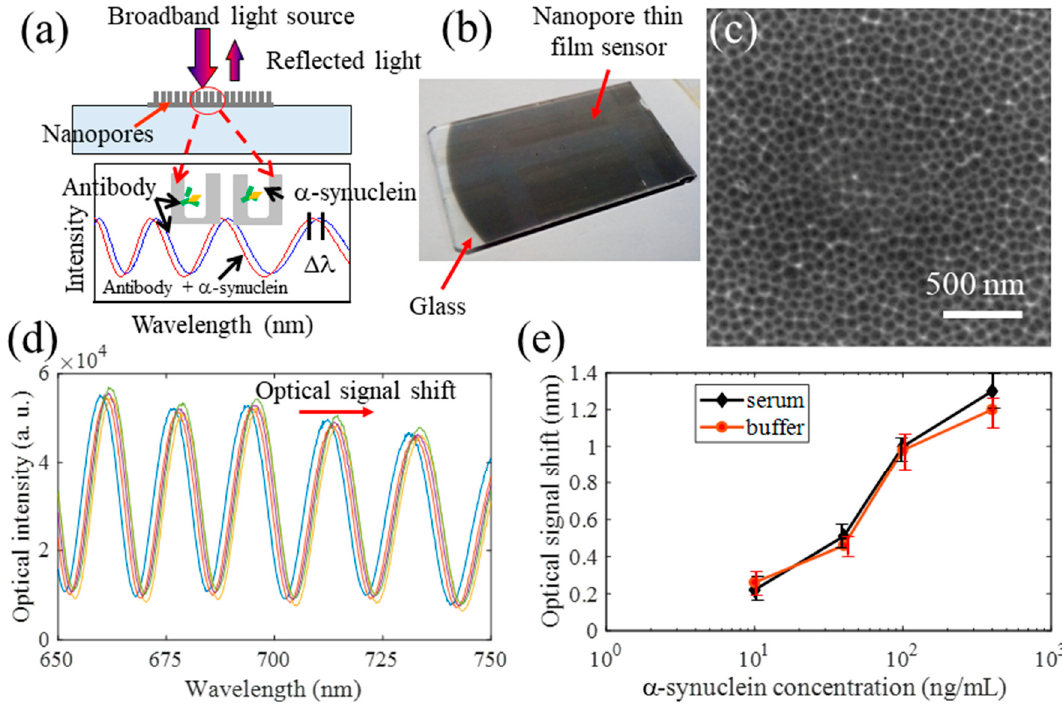
Figure 11. ( a ) Schematic of the nanopore thin film sensor on glass; ( b ) photo of a nanopore thin film sensor fabricated on glass; ( c ) SEM images of the nanopores in the sensor; ( d ) representative measured optical signals (i.e., interference fringe shift) with increased concentrations of α -synuclein in buffer and ( e ) measured optical signals of α -synuclein in buffer and spiked in serum.